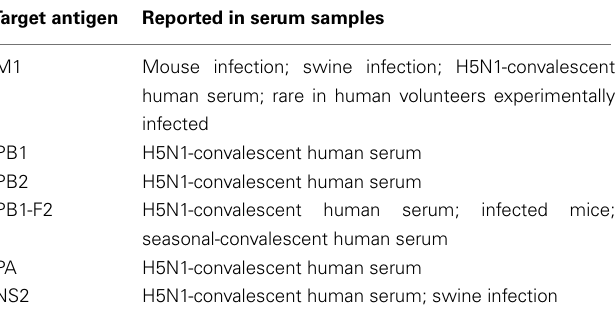
Table 3 |Antibodies with unknown efficacy against influenza